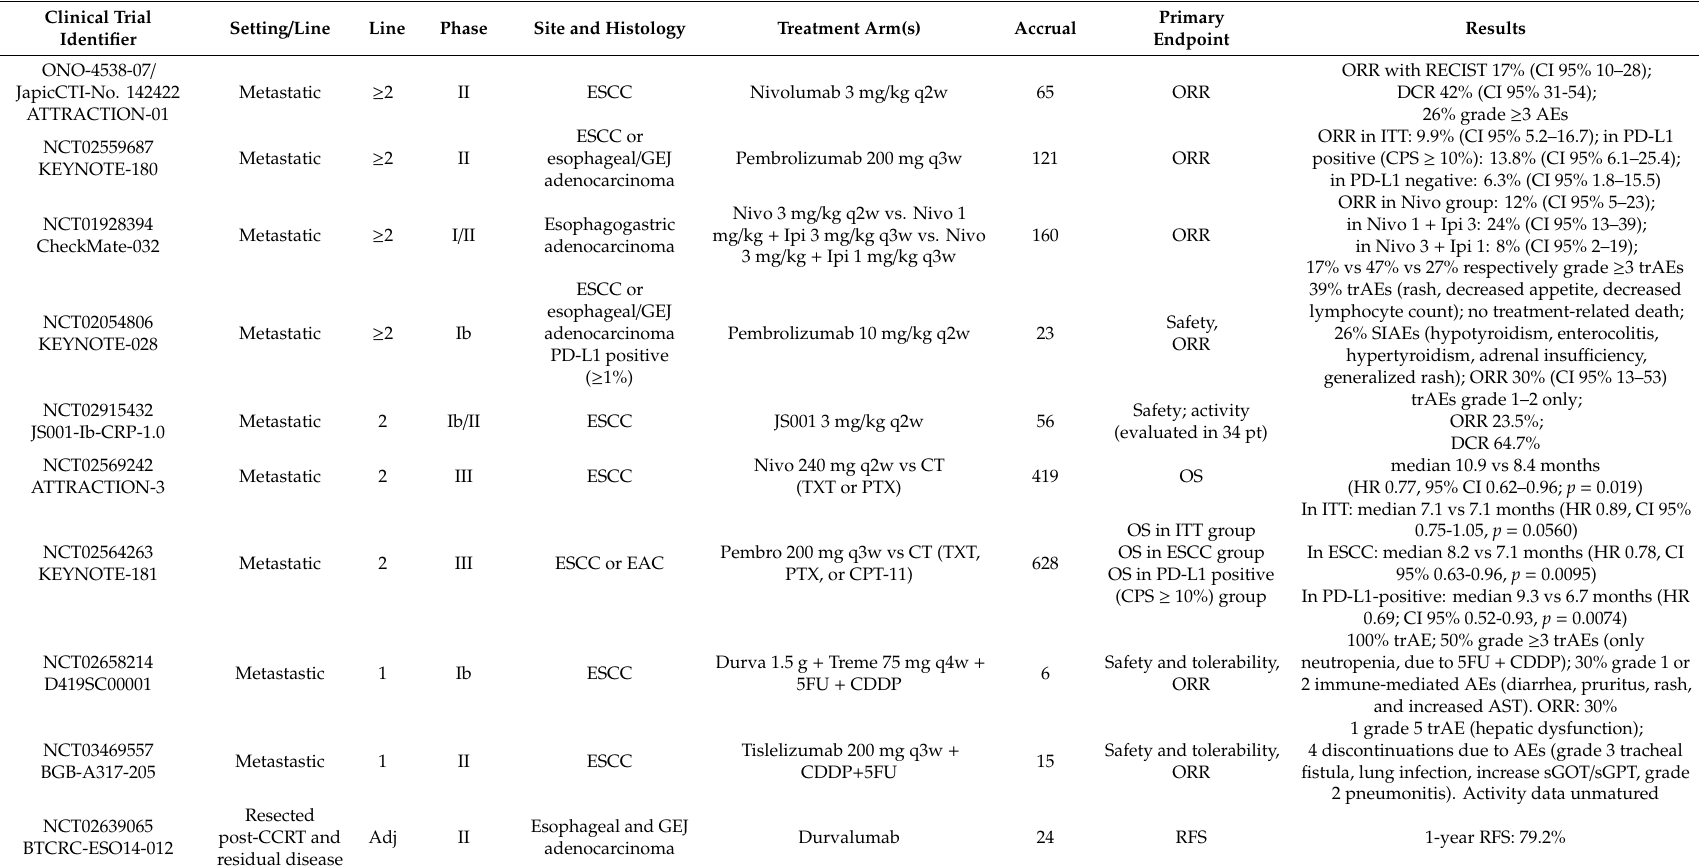
Table 1. Summary of selected presented trials in esophageal